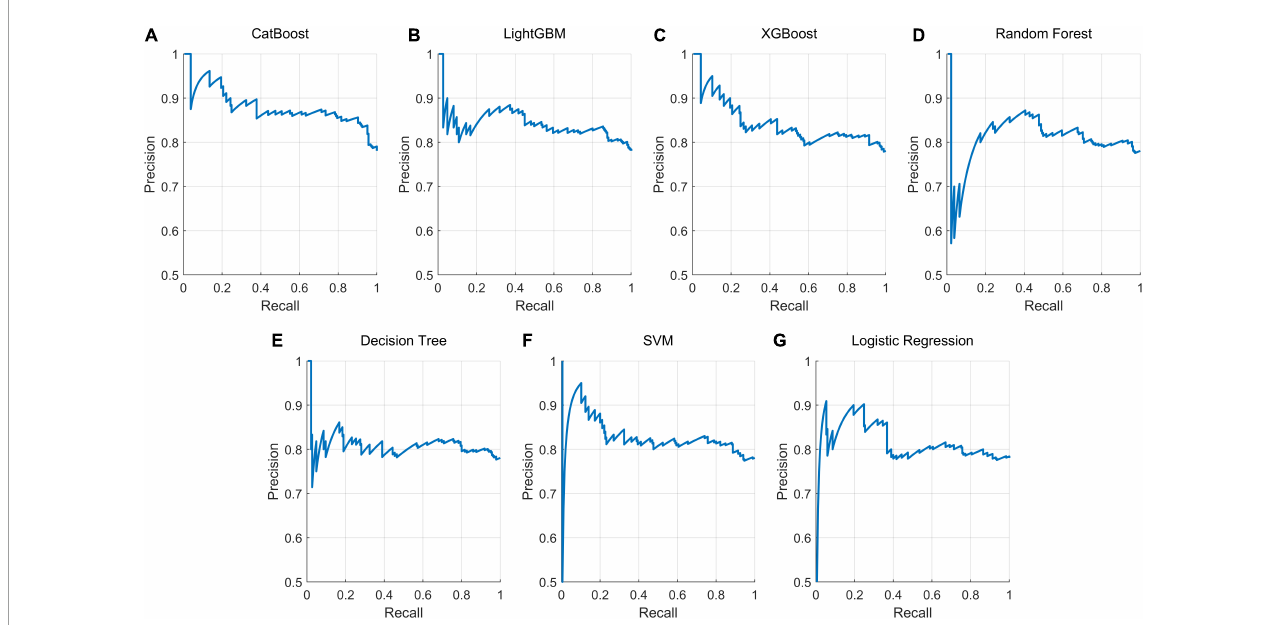
FIGURE3 Precision-recall curve for each trained model in predicting client psychotherapy satisfaction. The precision-recall curve for each prediction model predicts whether the participant is satisfied with psychotherapy. Seven machine learning algorithms were selected for training, namely, (A) CatBoost, (B) LightGBM, (C) XGBoost, (D) random forest, (E) decision tree, (F) support vector machine (SVM), and (G) logistic